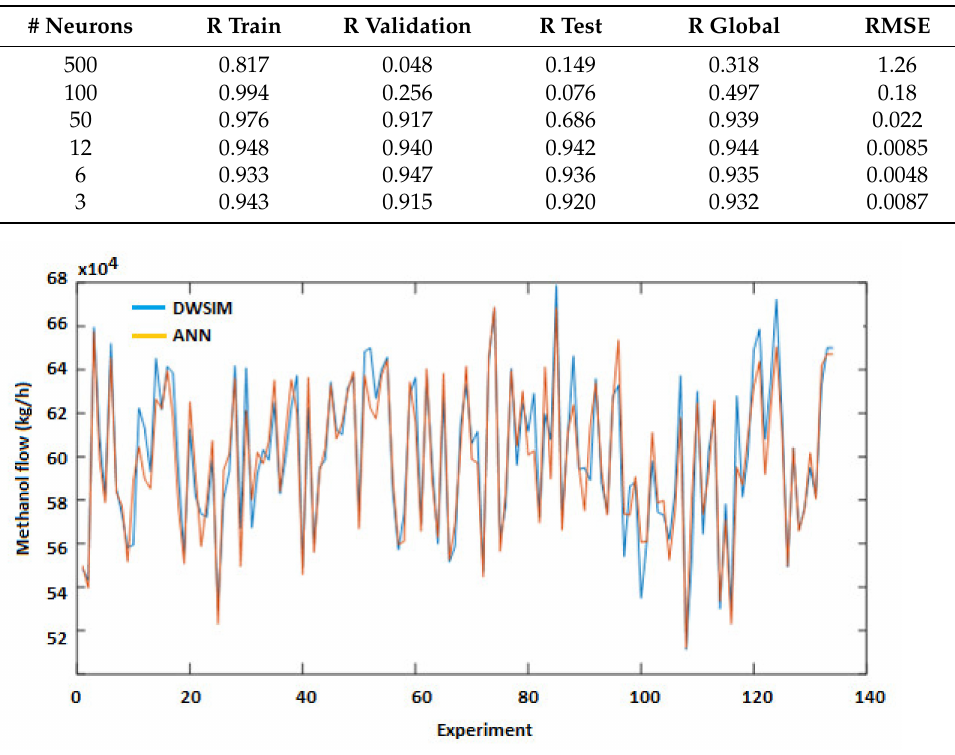
Figure 9. Comparative graph of the experimental data (DWSIM) and ANN predictions regarding methanol flux